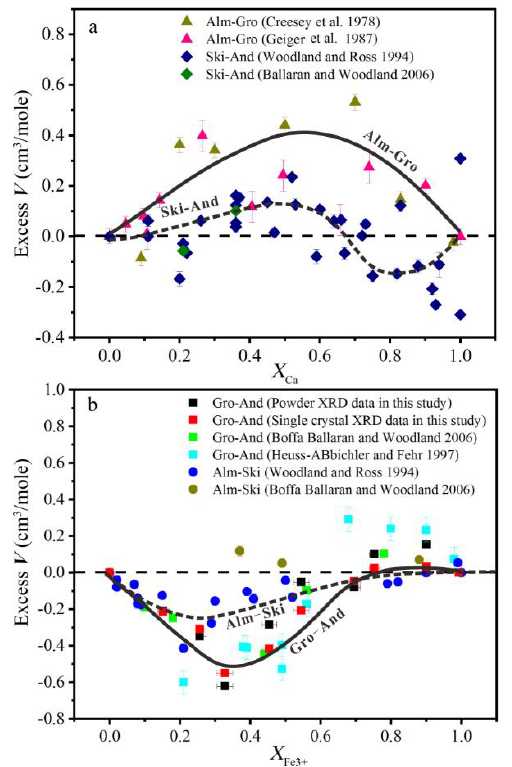
Figure 7. Excess volumes of mixing in ( a ) almandine–grossular and skiagite–andradite solid solutions and ( b ) grossular–andradite and almandine–skiagite solid solutions.